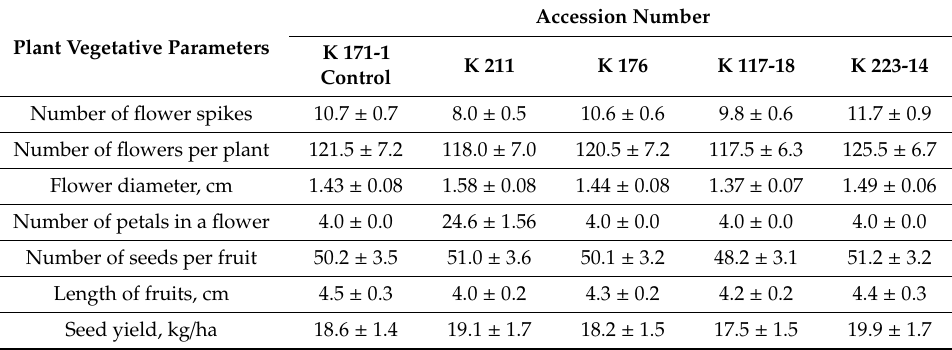
Table 1. Plant vegetative parameters in the studied C. majus populations.